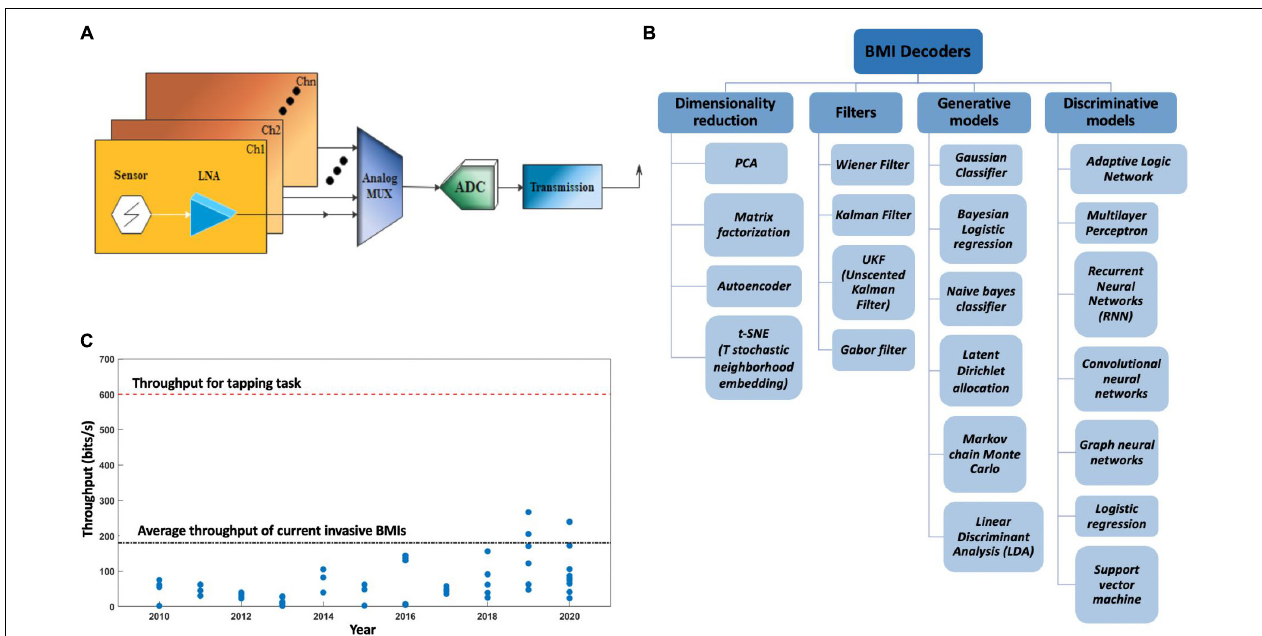
FIGURE 12 | (A) Schematics of a brain machine interface’s electrical circuit. LNA, low noise amplifier; MUX, analog signal multiplexer; ADC, analog to digital converter; Ch, channel. (B) Different types of BMI decoders used in signal post processing. (C) Information throughput over the years, blue dots represent the throughputs of invasive and non-invasive BMIs as reported in different published articles over the